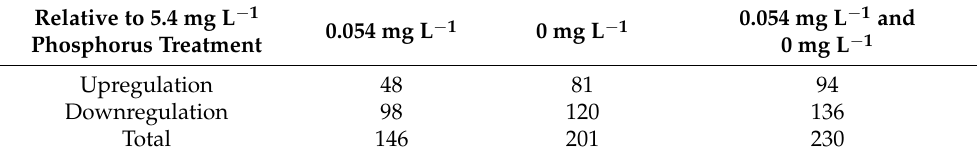
Table 1. Number of differentially abundant proteins in Microcystis aeruginosa FACHB-905 upon phos- phorus depletion. The differentially abundant proteins reported were upregulated or downregulated in the phosphorus depletion treatments (0.054 mg L − 1 and 0 mg L − 1 initial phosphorus concentra- tions) with a fold change relative to 5.4 mg L − 1 phosphorus treatment. Proteins with more than a 1.5-fold change ( ≥ 1.5 (upregulation) or ≤ 0.67 (downregulation)) containing at least two unique